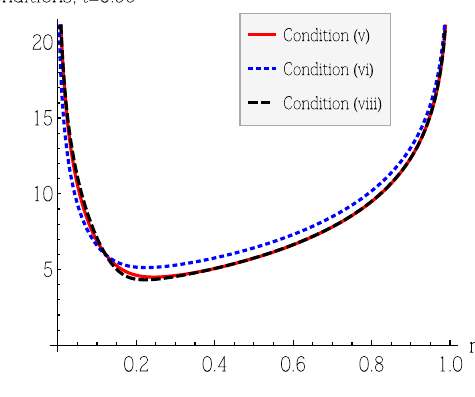
Fig. 15 Conditions (i), (ii), (iv) at t = 0 . 99